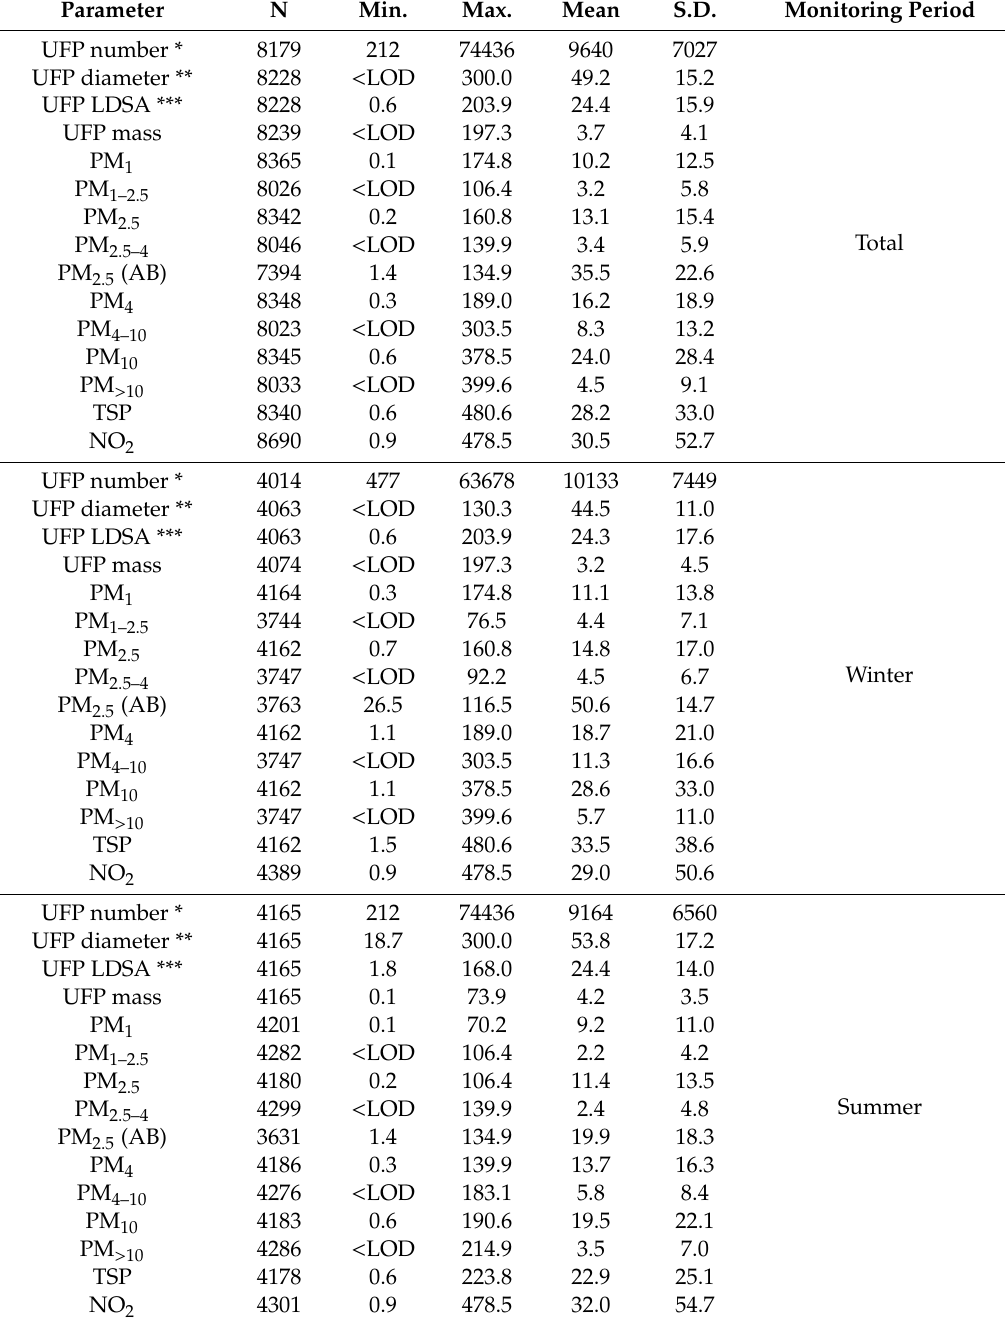
Table 1. Descriptive statistic performed on the total dataset and for the winter and summer campaigns (N: Number of Data; Min.: Minimum; Max.: Maximum; S.D.: Standard Deviation; LDSA: ung Deposited Surface Area; PM 2.5 (AB): PM 2.5 Measured via AirBeam). Data are reported as µ gm 3 (* article / cm 3 ; ** nm; *** µ m 2 / cm 3 ). Data in italics refer to those used for the calculation of UFP